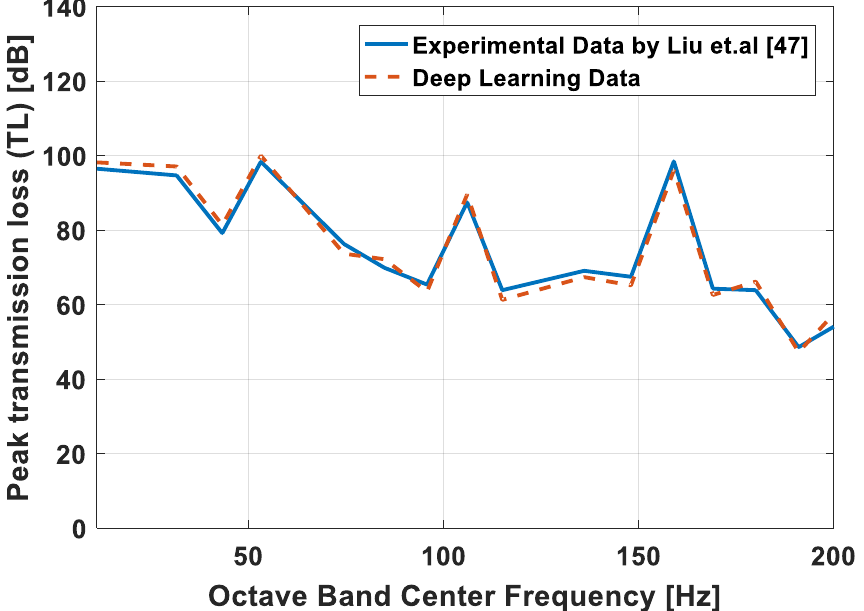
Figure 12. Comparison between the proposed method and experimental values of Peak transmission loss (TL) of the muffler.